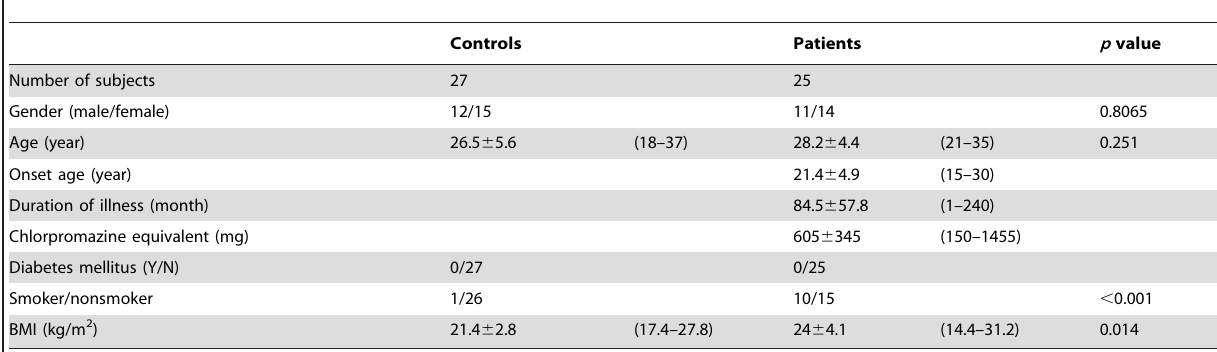
Table 1. Characteristics of